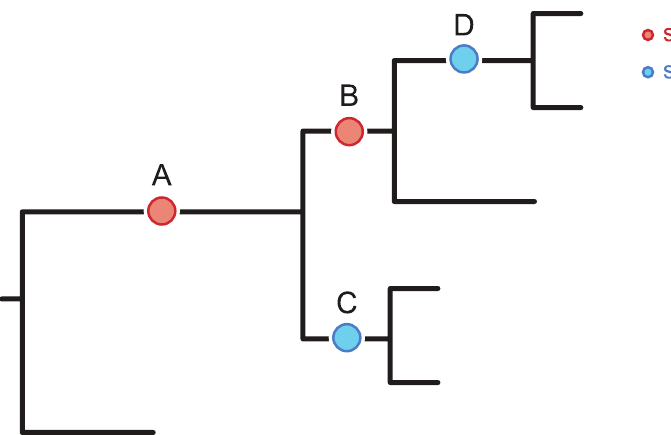
Figure 1. Detecting positive epistasis between mutations at two sites, i and j . The epistasis statistic is defined in terms of the total time elapsed between all pairs of consecutive substitutions at sites i and j (see ‘‘Materials and Methods’’). In this schematic figure, substitutions at sites i and j are denoted by red and blue circles, respectively. Substitutions ( A , C ) and ( B , D ) form consecutive pairs. Substitutions ( B , C ) are not consecutive because they occur on different lineages. Substitutions ( A , D ) are not consecutive because substitution B at site i occurs between them.